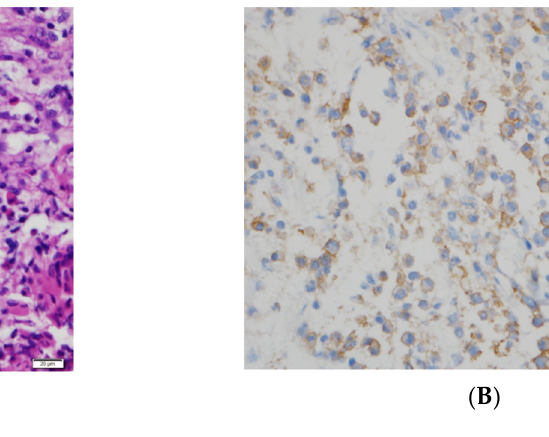
Figure 2. Biopsy results from the right periorbital mass. ( A ) Abundant Langerhans cells are seen, with scattered eosinophils and multinucleated giant cells (hematoxylin and eosin). ( B ) CD1 immunostaining demonstrates a membranous staining pattern with perinuclear dots.